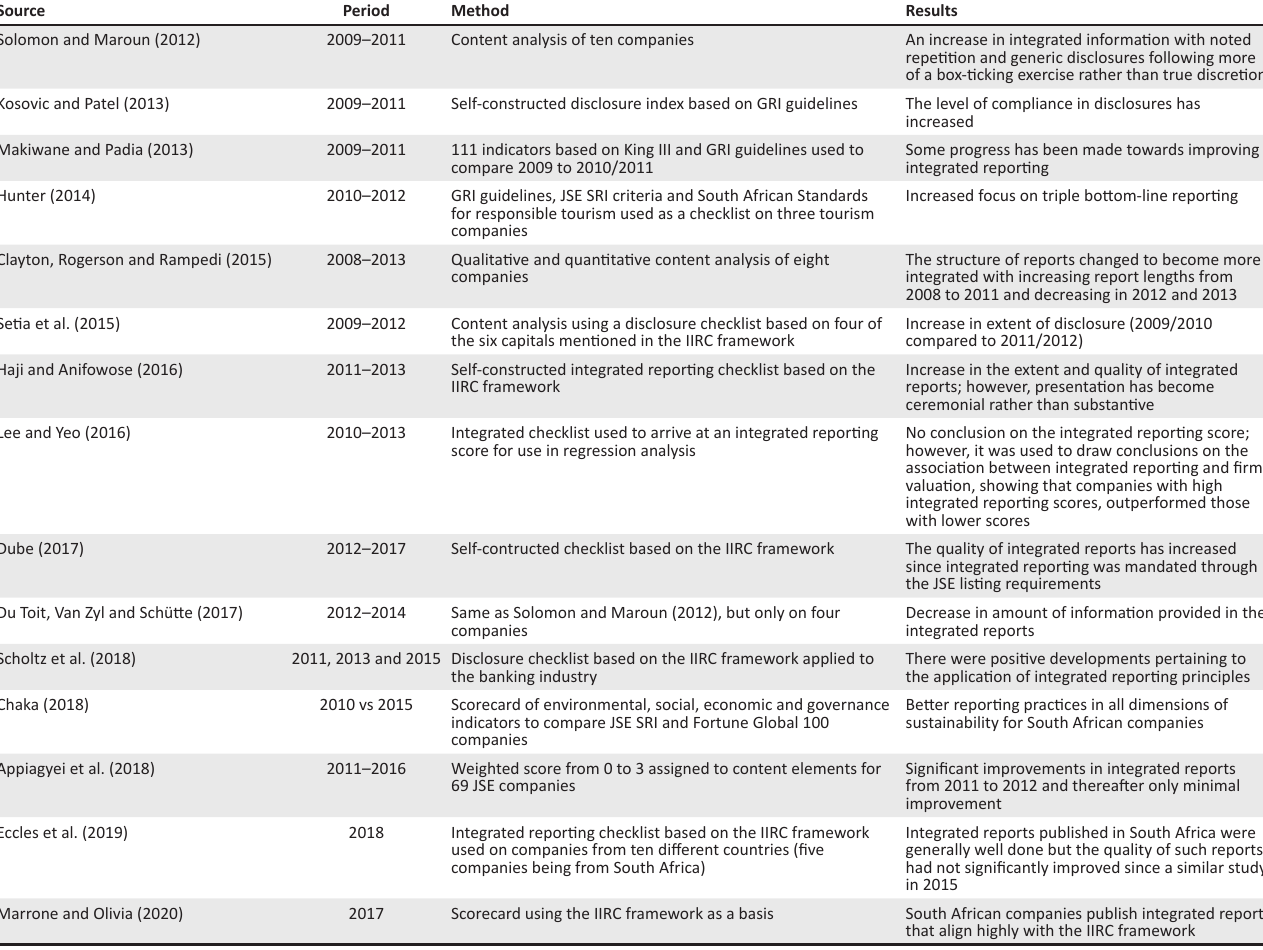
TABLE 1: Summary of studies on the impact of integrated reporting guidelines in South Africa.